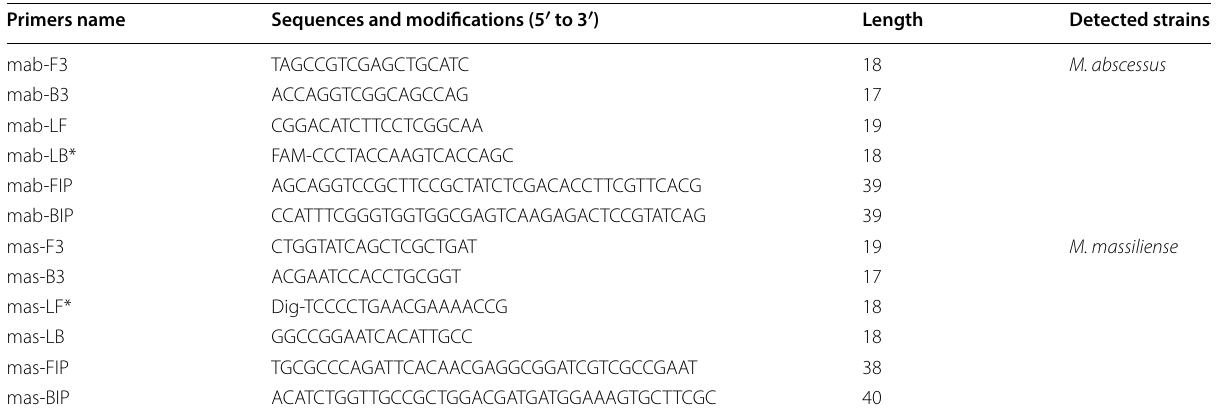
Table 2 Primers used in this study Primers name Sequences and modifications (5 ′ to 3 ′